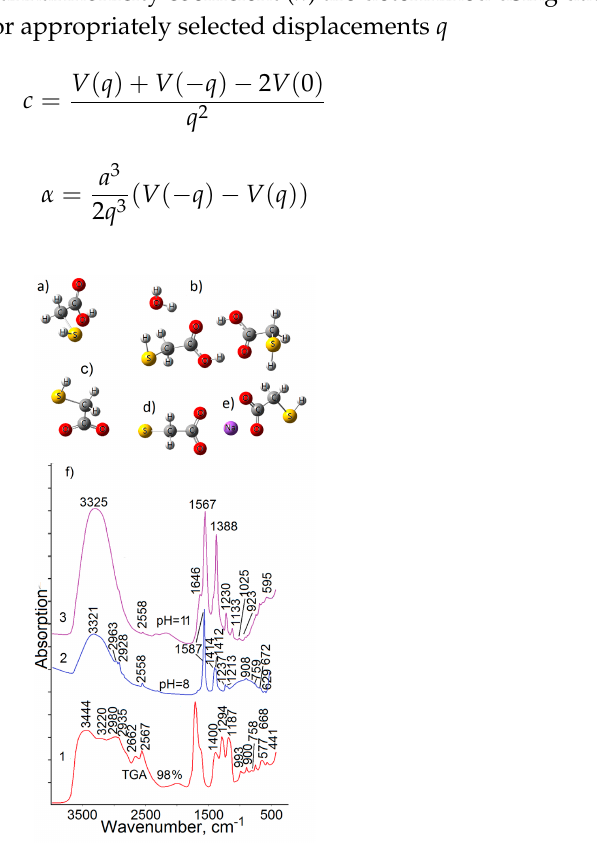
Figure 1. Structure of TGA, its associates and ionic forms and their FTIR spectra. (a) monomer; (b) cyclic dimer and water molecule; (c) dTGA; (d) ddTGA; (e) sodium thioglycolate; (f) FTIR spectra of TGA solutions, recorded at different pH